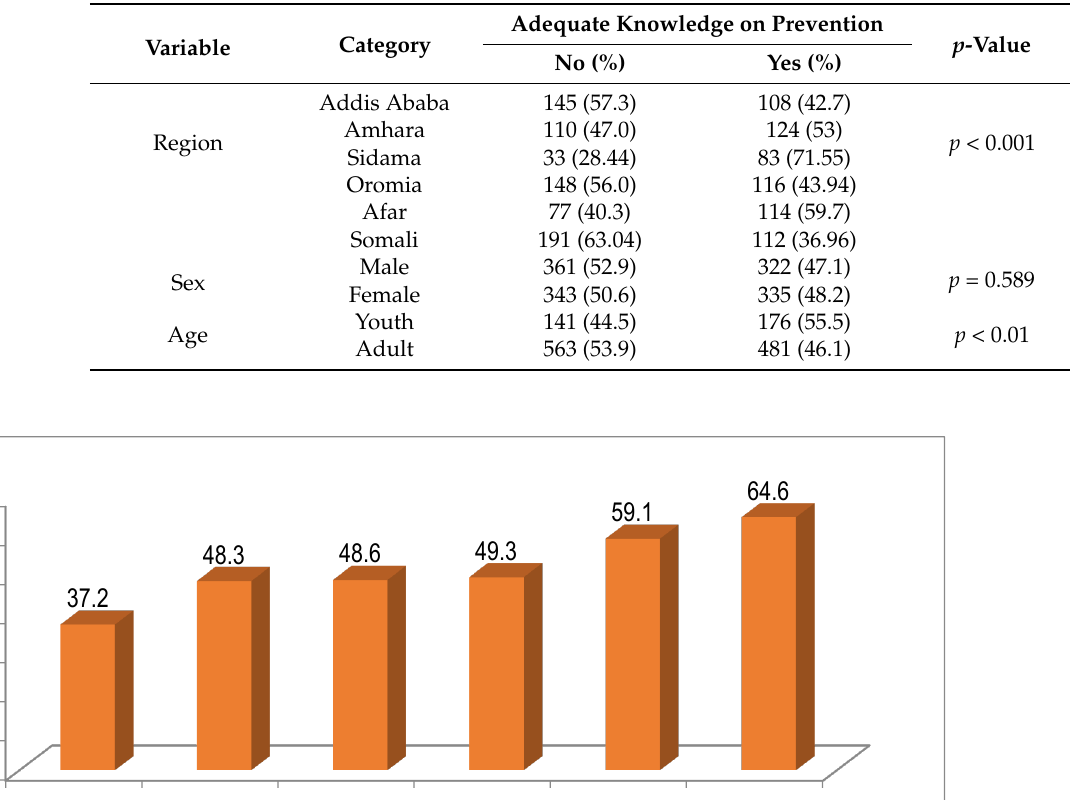
Table 3. Level of knowledge by region, sex, and age regarding COVID-19 prevention methods at the time of the COVID-19 hesitancy survey in Ethiopia, 2022.